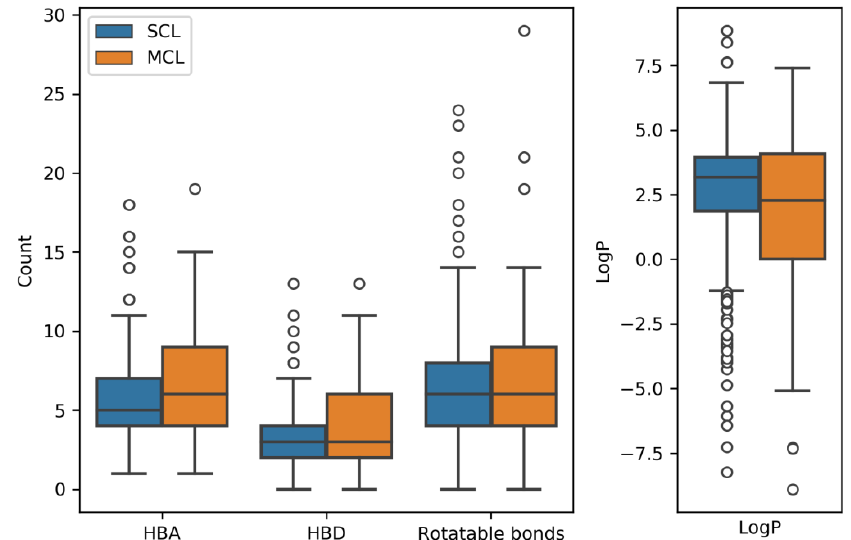
Figure 5. Molecular properties of SCLs and MCLs. Boxplots report the distributions of the number of hydrogen bond acceptors (HBA), hydrogen bond donors (HBD), and rotatable bonds, as well as of the logarithm of the octanol-water partition coefficient (LogP).